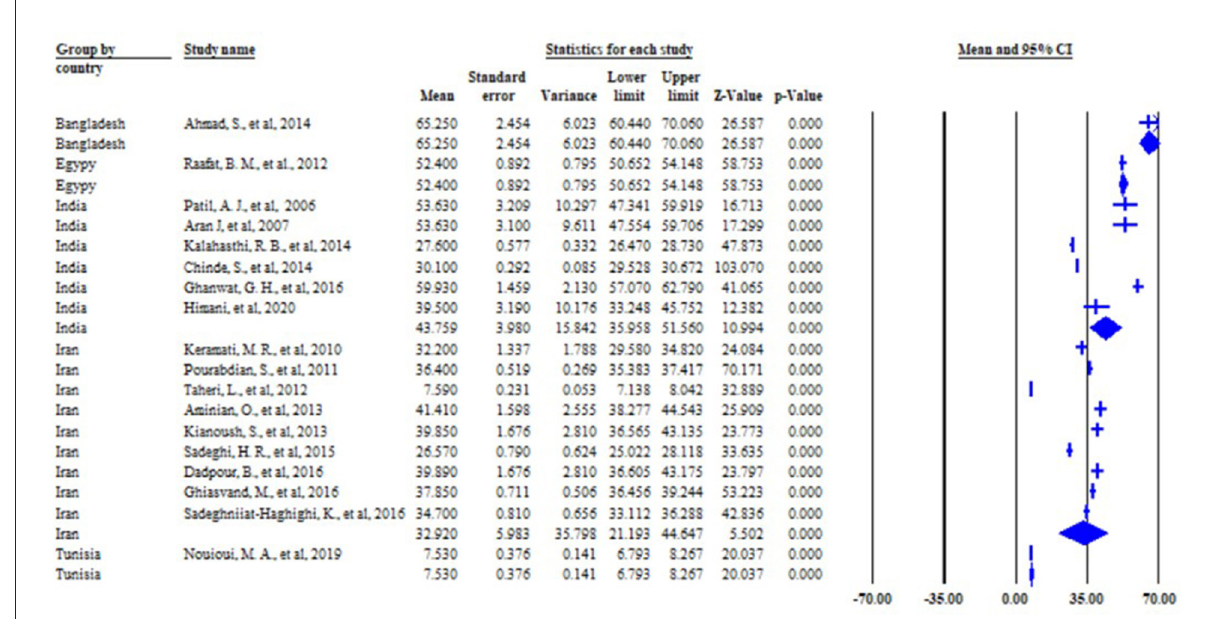
FIGURE3 Figure subgroup analysis by the country level of the mean of BLL among lead battery workers in LMIC, 2022 ( n = 18).